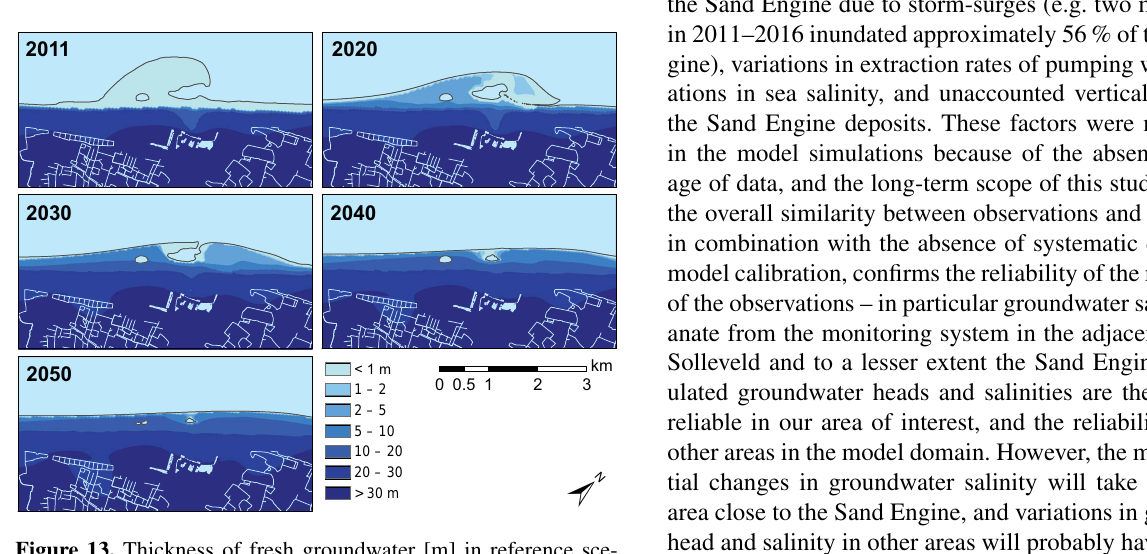
Figure 13. Thickness of fresh groundwater [m] in reference sce- nario near the Sand Engine from 2011 to